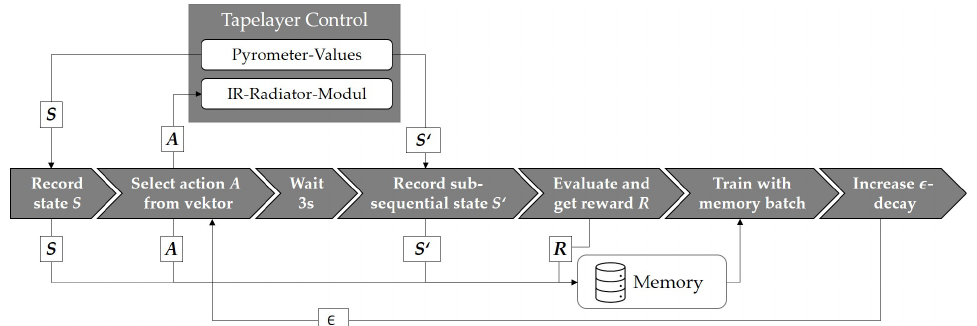
Figure 6. Process of the iterative training method for the DDPG agent.